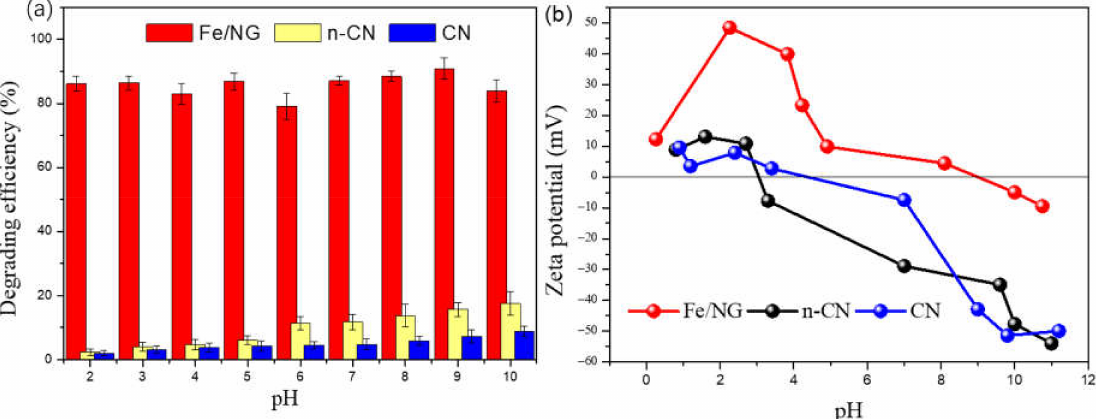
Figure 7. ( a ) Effect of pH values on the degradation of MB with Fe/NG: C 0MB = 50 mg L − 1 ,